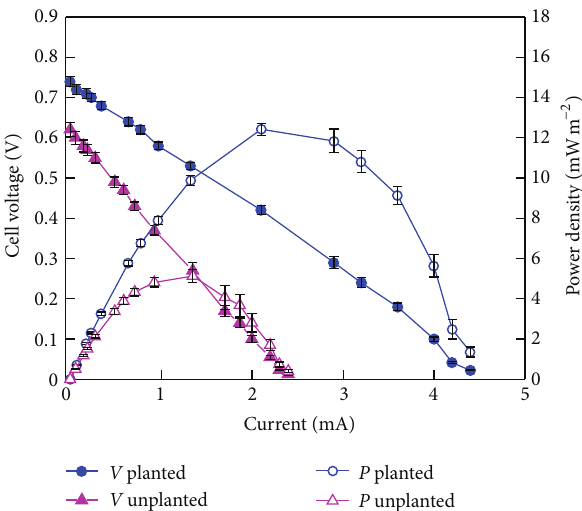
Figure 3: Polarization curves of the planted CW-MFC and unplanted CW-MFC (solid symbols for the cell voltage and open symbols for the power